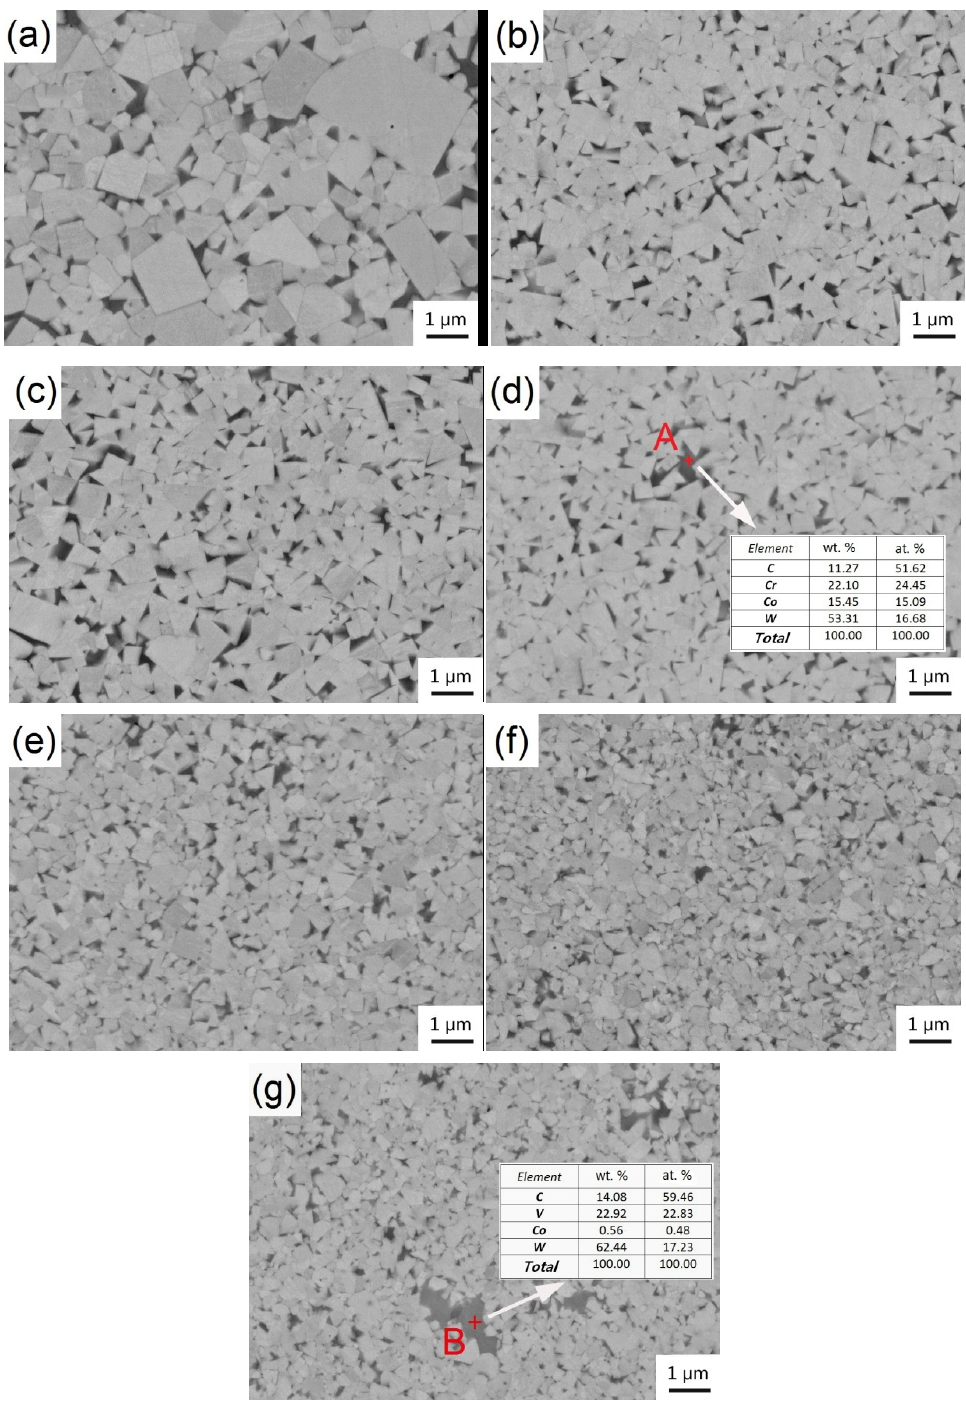
Figure 3. SEM images showing microstructures of WC–6Co–(Cr 2 C 3 /VC) cemented carbides sintered at 1450 °C. ( a ) WC–6Co; ( b ) WC–6Co–0.25Cr 3 C 2 ; ( c ) WC–6Co–0.6Cr 3 C 2 ; ( d ) WC–6Co–1.0Cr 3 C 2 ; ( e ) WC–6Co–0.25VC; ( f ) WC–6Co–0.6VC and ( g ) WC–6Co–1.0VC.